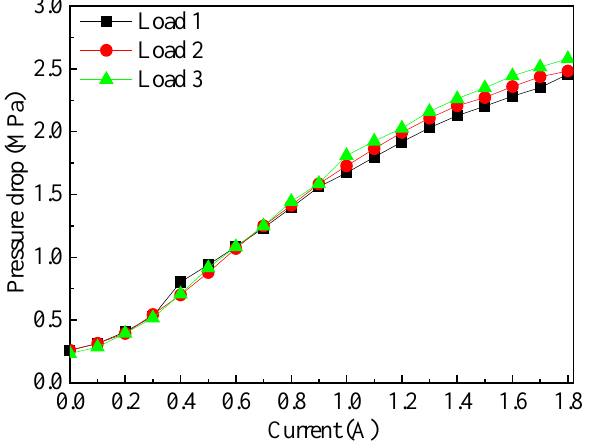
Figure 23. Experimental pressure drop of the optimal radial MR valve under different